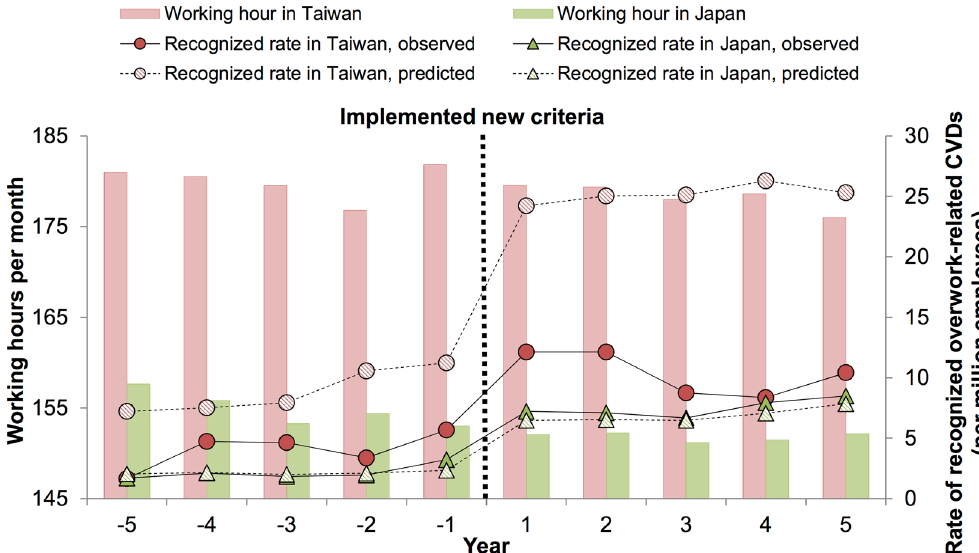
Figure 1. Trends of working hours per month and rates of recognized overwork-related cardiovascular and cerebrovascular diseases (CVDs) in Taiwan and Japan from the 5-year period before and after launch of the new criteria. Note: Predicted rates of recognized overwork-related CVDs (dashed lines) were based on the modeling results from Table 6, given that both countries were at the same level of recognition system for work-related diseases, i.e., Japanese system, and their working conditions remained